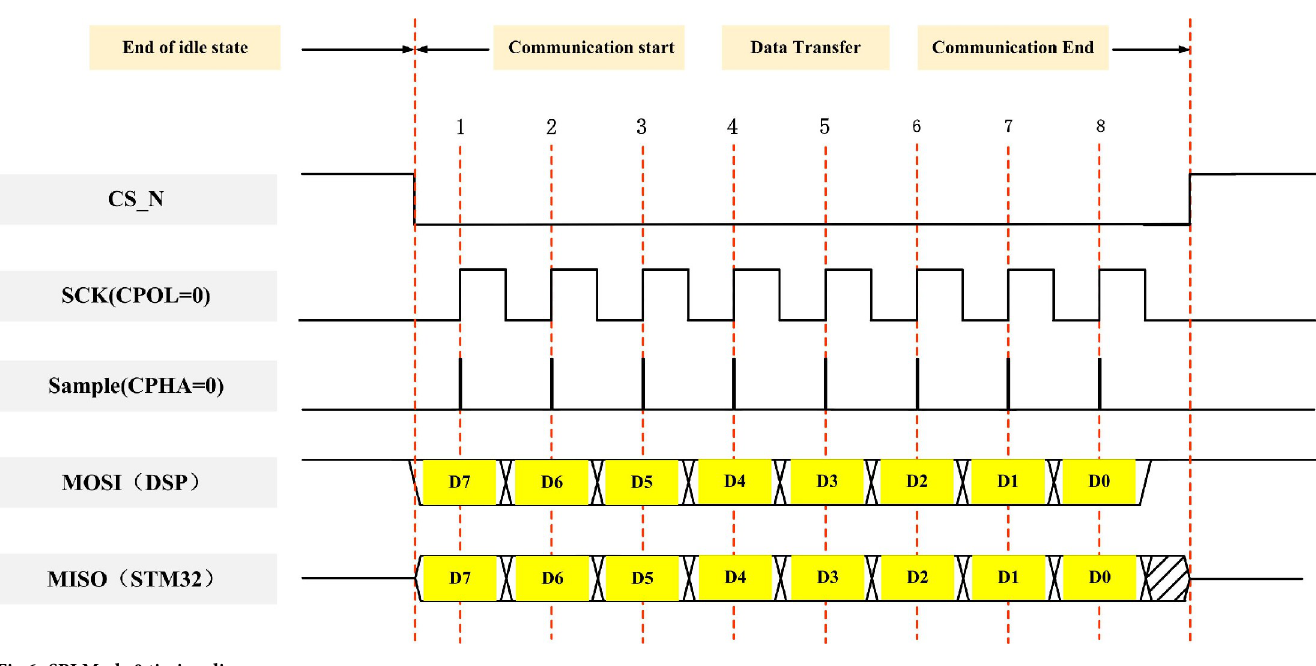
Fig 6. SPI Mode 0 timing